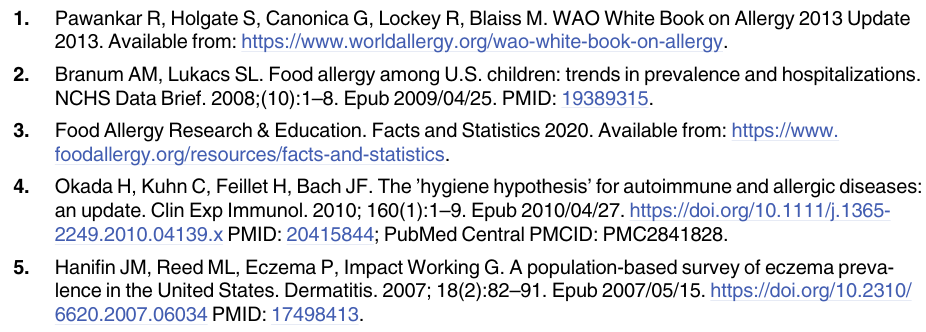
S4 Fig. Epicutaneous sensitization with LD and allergen predisposes to the development of esophageal eosinophilia. A, B. Representative MBP stained sections of the esophagus (A) and numbers of MBP + eosinophils per HPF (B). Arrows in A indicate examples of eosinophils. Magnification, 100X. Scale bars: 100 μ m. n = 5 mice per group in A, B. Data are mean ± SEMs. ��� p < 0.001 obtained by nonparametric one-way ANOVA (B). ns, not signifi-